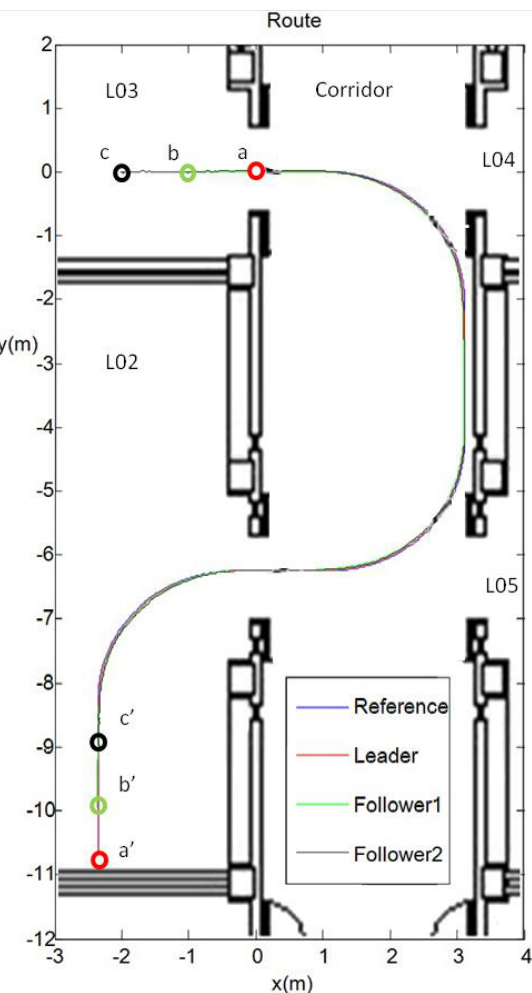
Figure 11. Trajectory followed by the platoon. The path described by the leader is plotted in red, the one described by the first follower is shown in green, and the one described by the second follower is plotted in black. The reference trajectory input to the leader is also shown in